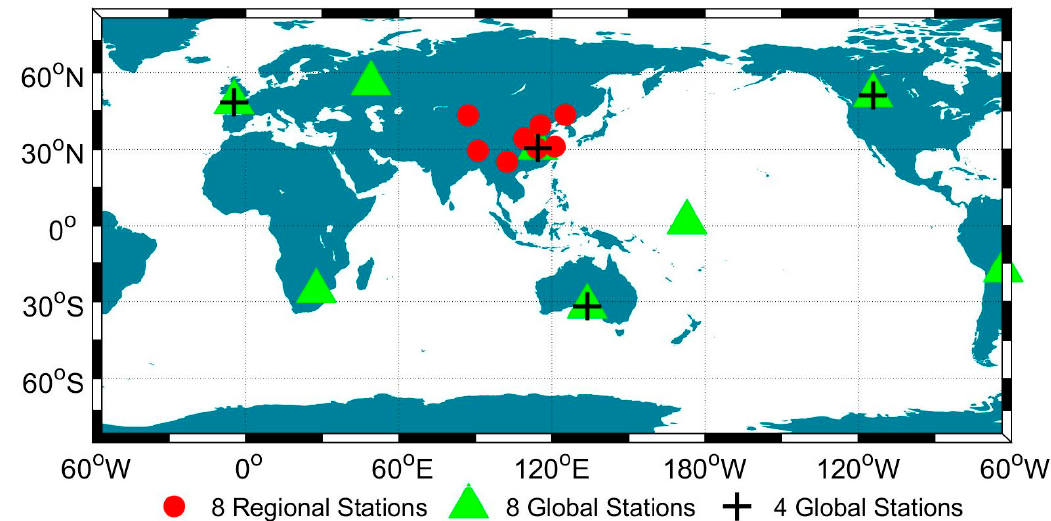
Figure 10. Distribution of a small number of ground stations.